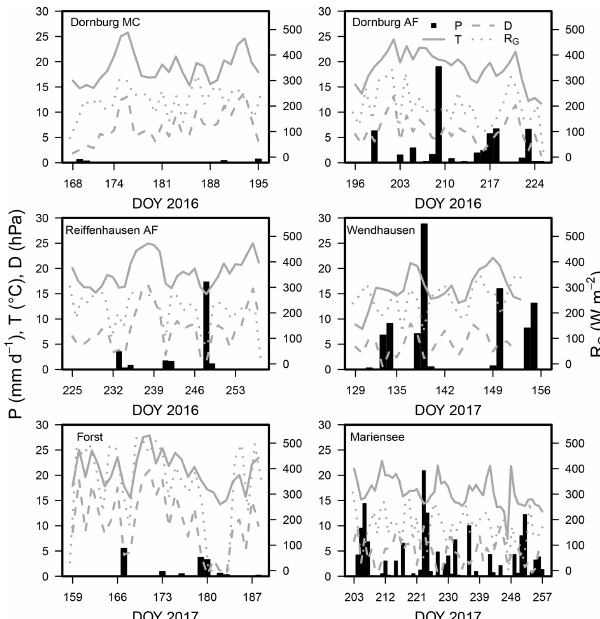
Figure 2. Time series of daily mean air temperature ( T ; ◦ C), vapour pressure deficit ( D ; hPa), daily summed precipitation (mmd − 1 ; left y axis), and daily mean global radiation ( R G ; Wm − 2 ; right y axis) for all sites. The data for AF and MC of the respective sites of Forst, Mariensee, and Wendhausen were averaged. The field campaigns at the AF and MC systems were conducted during the same time, and we assumed similar weather conditions due to the small distance between the AF and MC